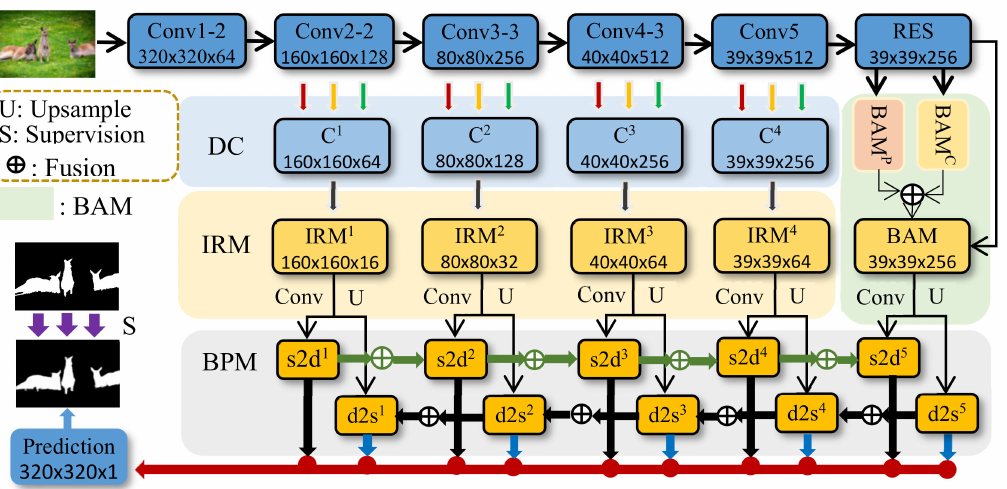
Figure 3. The overall framework of the model. IRM: interactive residual model. BAM: balanced- attention model. BPM: bidirectional propagation model. DC: hollow convolution. RES: residual structure. U: upsampling. S: supervision. s2d: from shallow to deep. d2s: from deep to